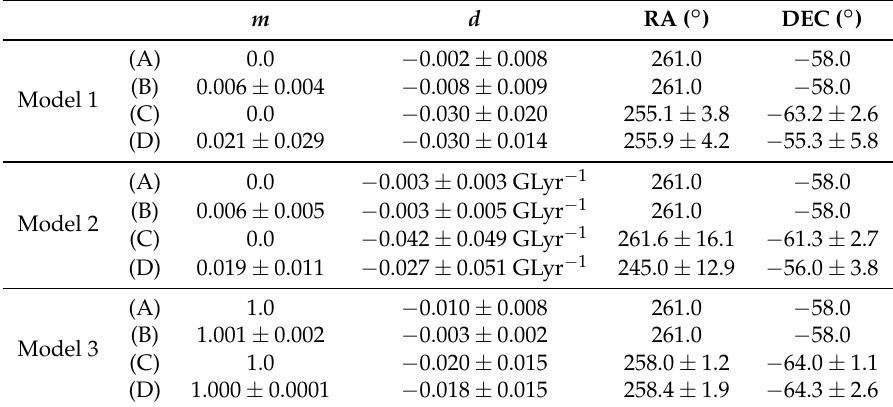
Table 1. Results of the analysis for Models 1, 2 and 3 from